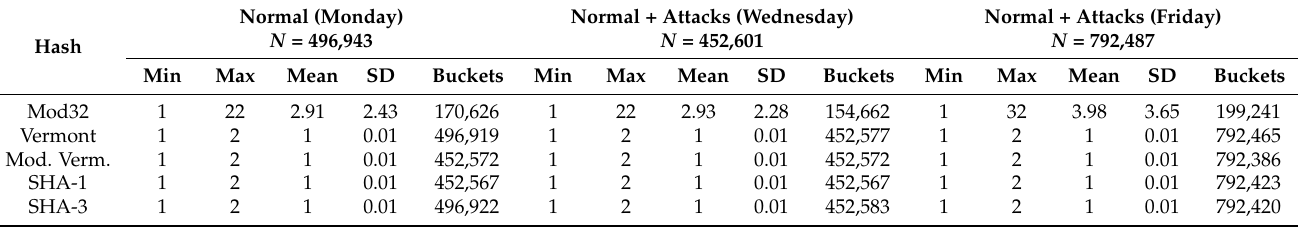
Table 7. Statistics of bucket occupation for various hash functions—2 32 buckets